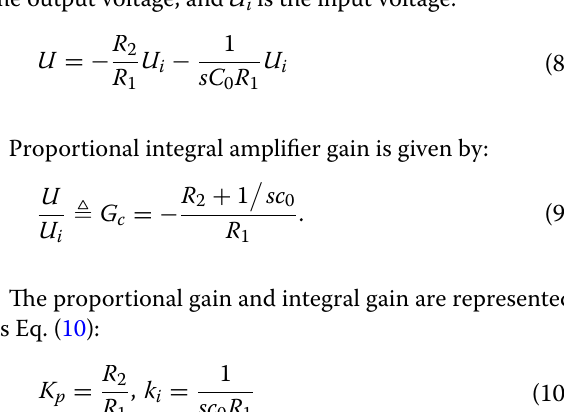
circuit representation of the proportional integral con- troller based on the operational amplifier is presented in Figure 2.